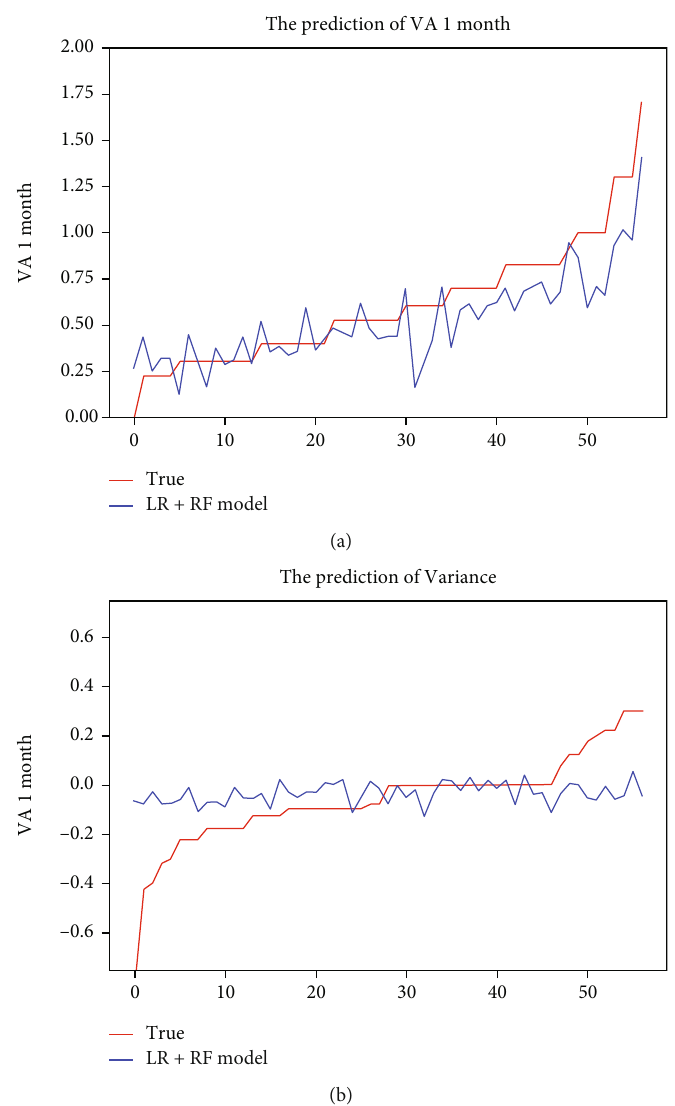
Figure 5: Visual acuity prediction fi tting curve in di ff erent models. (a) fi tting curve for VA predictions; (b) fi tting curve for VA variance